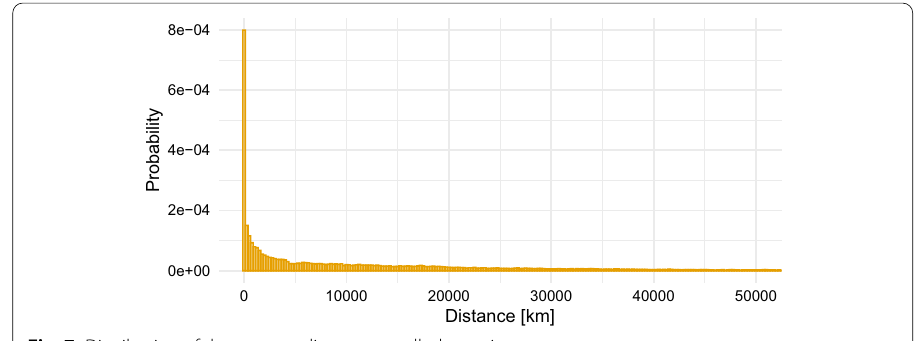
Fig. 7 Distribution of the average distance travelled per